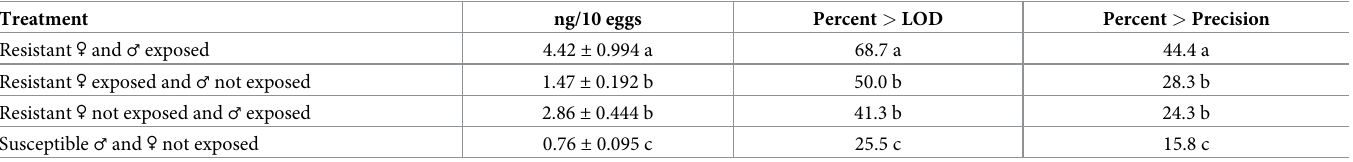
Table 2. Cry1F detected (ng/10 eggs) and percent of the technical replicates greater than the limit of detection (LOD) and greater than measurement precision in the first five egg masses of Spodoptera frugiperda exposed or not to Cry1F (±95% CI) as larvae from ten days after eclosion until pupation ( n = 10 couples/treatment, 5 egg masses per couple, 5 technical replicates per egg